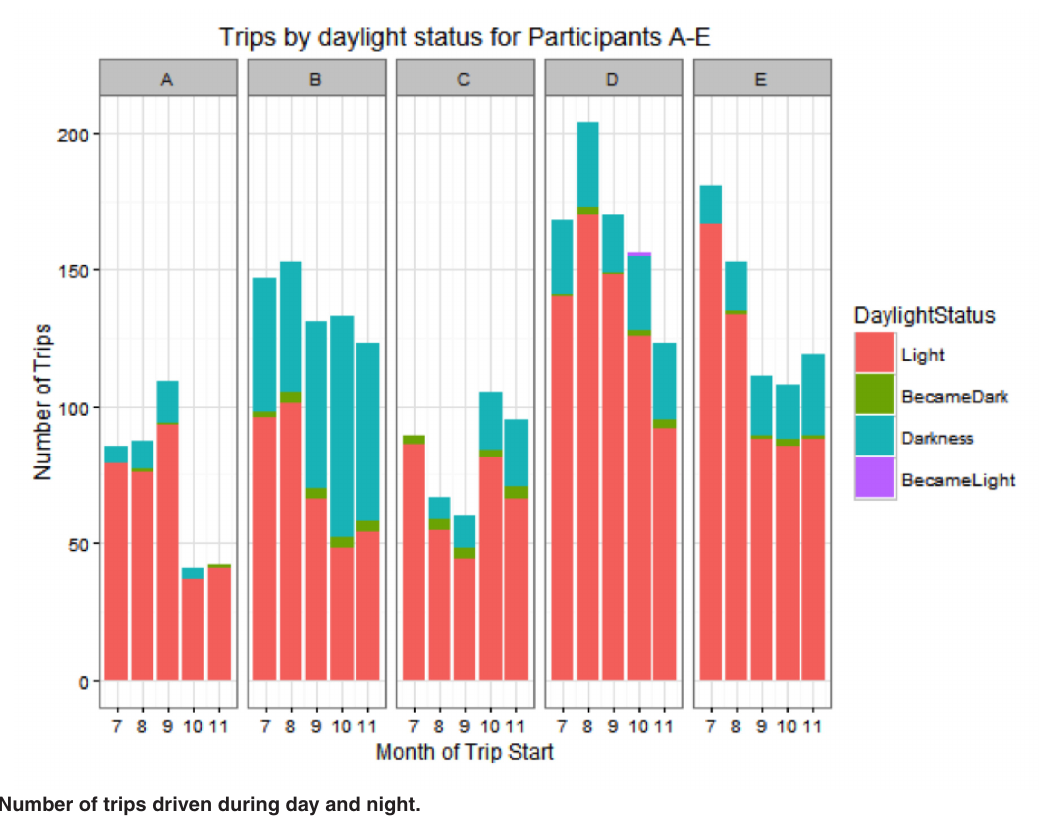
months.Figure 9. Number of trips driven during day and